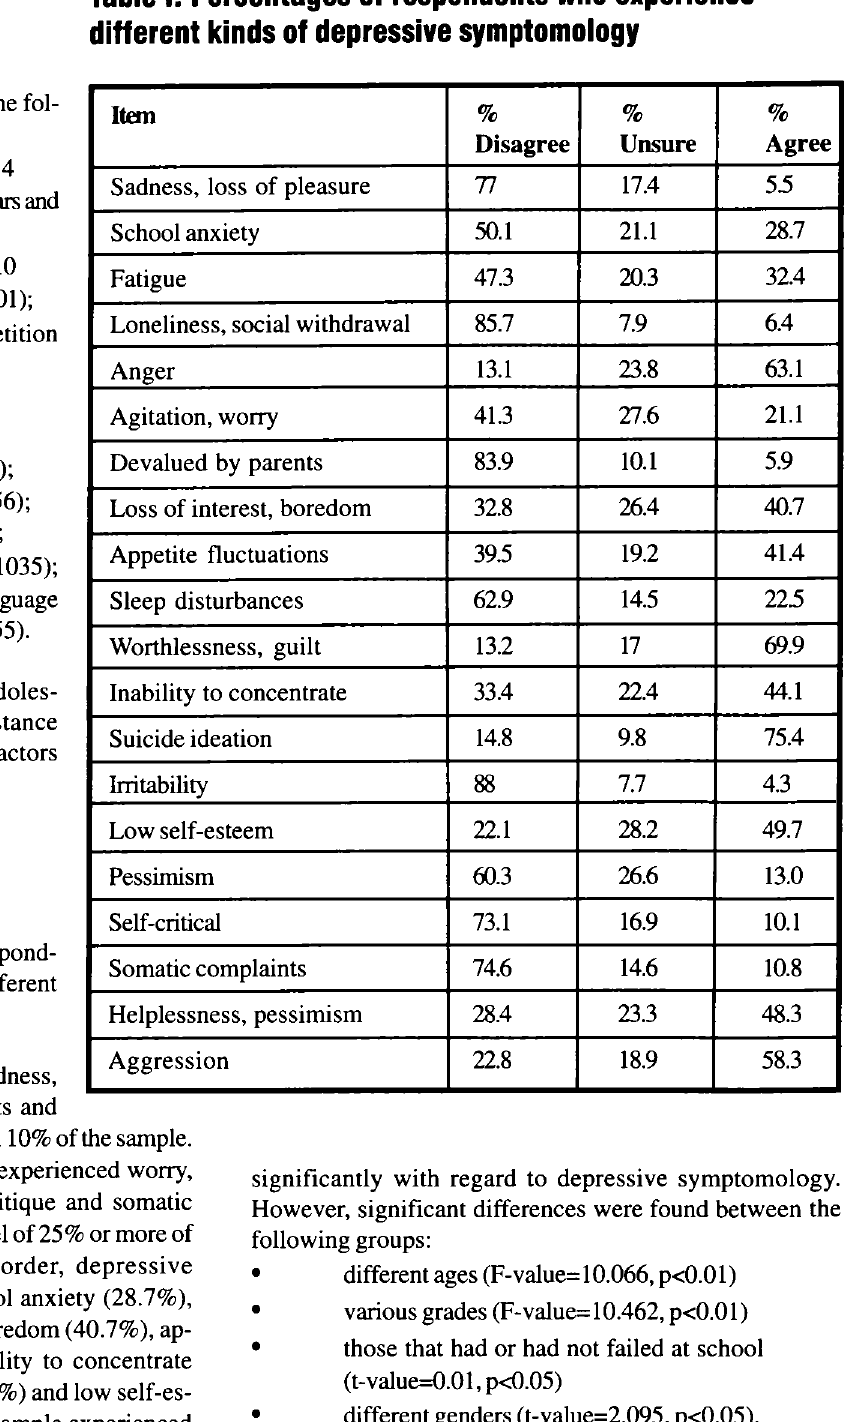
Table I: Percentages of respondents who experience different kinds of depressive